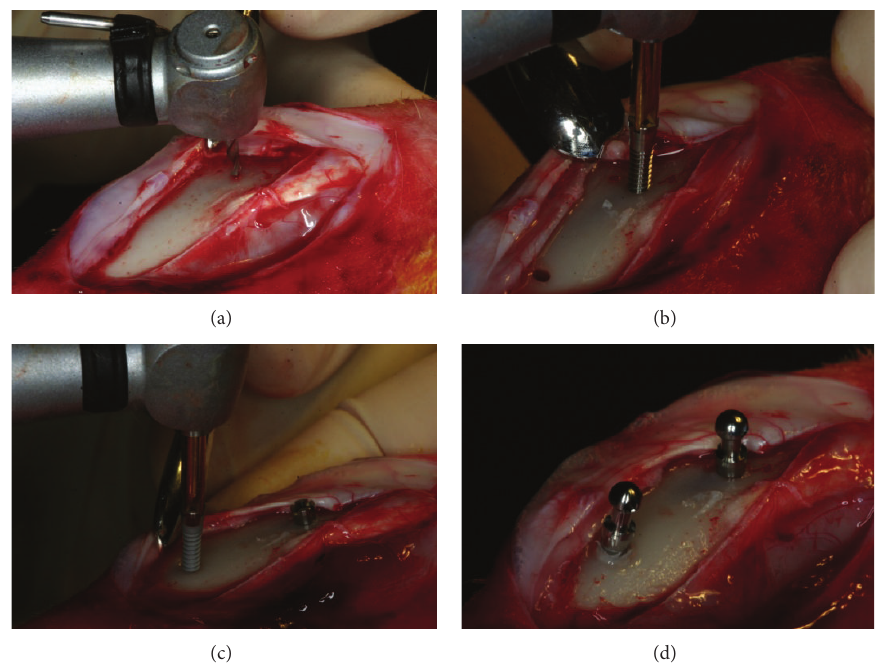
Figure 3: Orthodontic mini-implants placed in rabbit tibia ((a) predrilling with guide drill of 1.5 mm width. (b) The machined surface mini-implants being inserted. (c) SLA surface-treated mini-implants being inserted. (d) The head part being connected on the screw part of